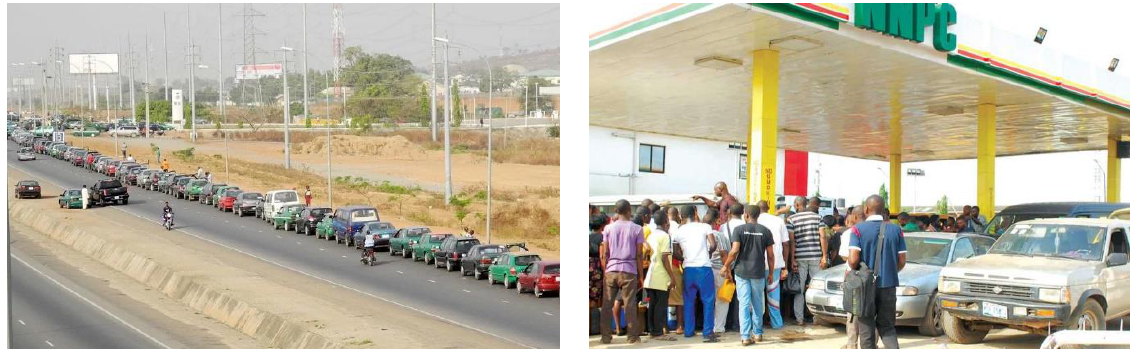
Fig. 1. Motorists waiting on long Queue during fuel scarcity in Abuja.